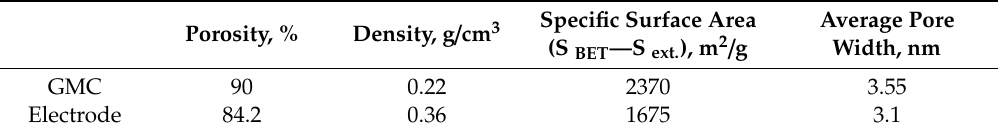
Table 5. Experimental results of physical characteristics of graphene-mesoporous carbon and electrode on its basis.